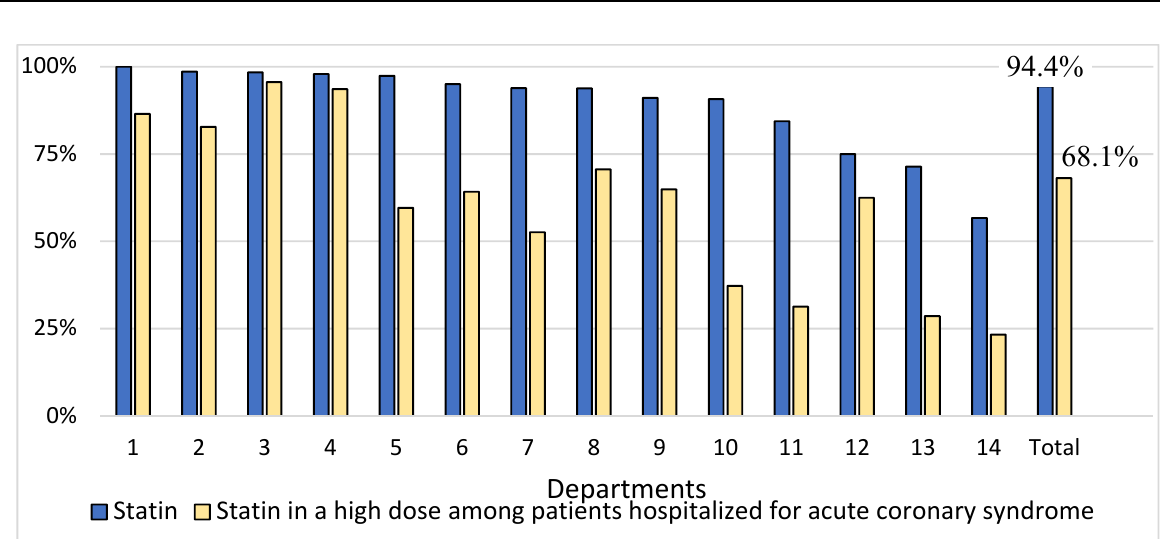
Figure 1. Proportions of patients prescribed a statin at discharge among all patients and statin in a high dose among those hospitalized for an acute coronary syndrome by departments.